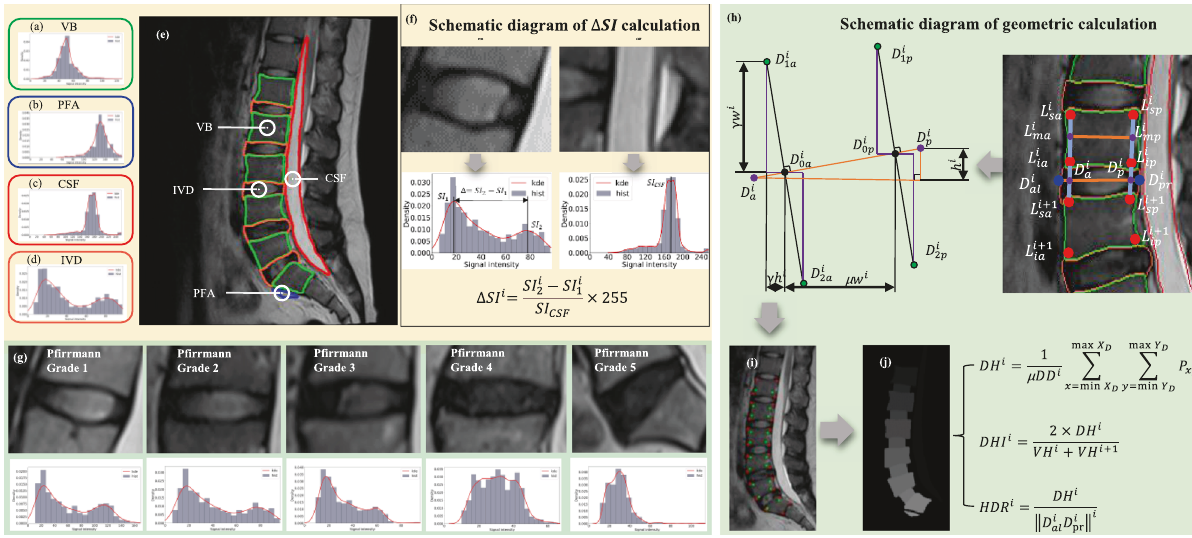
Fig. 5 Scheme diagram of IVD parameter calculation. Signal-intensity histogram calculation: ( a ) vertebral body area, ( b ) presacral fat area, ( c ) cerebrospinal fl uid area, and ( d ) intervertebral disc area. e The outline of the segmented area is displayed on the original image. f Schematic diagram of Δ SI calculation. g Signal-intensity histogram corresponding to different P fi rrmann grade. h A geometric calculation method of lumbar disc-height parameters based on area, ( i ) vertebral body corner detection result (red points) and feature-point calculation result (green points), and ( j ) 80% area-extraction result of the intervertebral disc